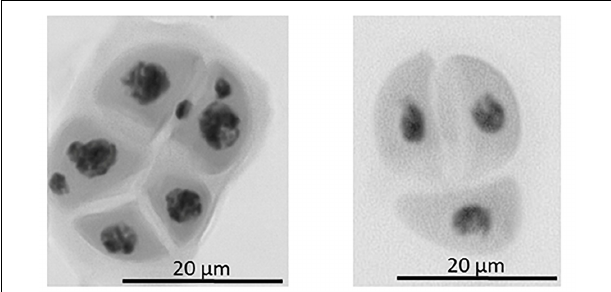
FIGURE 6 | Example of abnormal tetrad formation in the dmc1.c-3041 mutant. On the left: tetrad composed of five cells, two of the cells show the presence of two micronuclei. On the right: tetrad composed of three cells, no micronuclei are present.